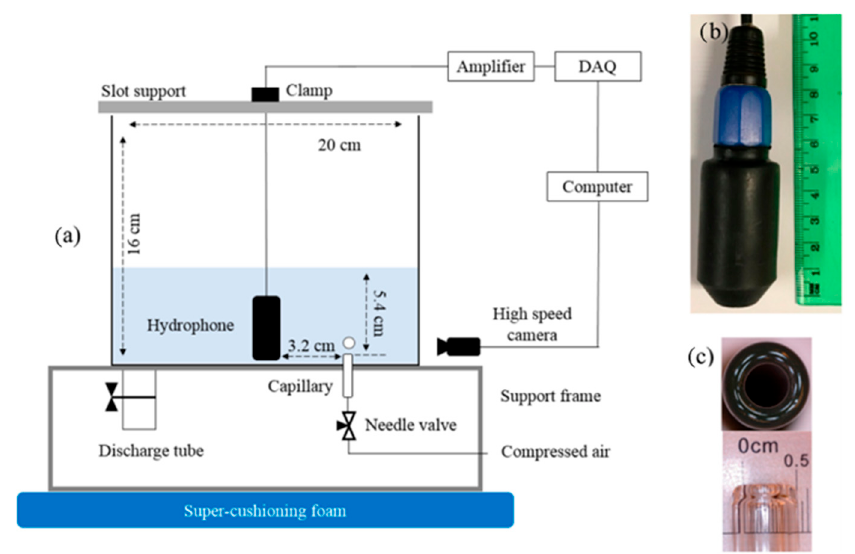
Figure 1. Experimental setup, adapted from Chu et al. (2017) [4]. Copyright 2017 ACS Publications. ( a ) overview of the entire setup, ( b ) hydrophone, and ( c )